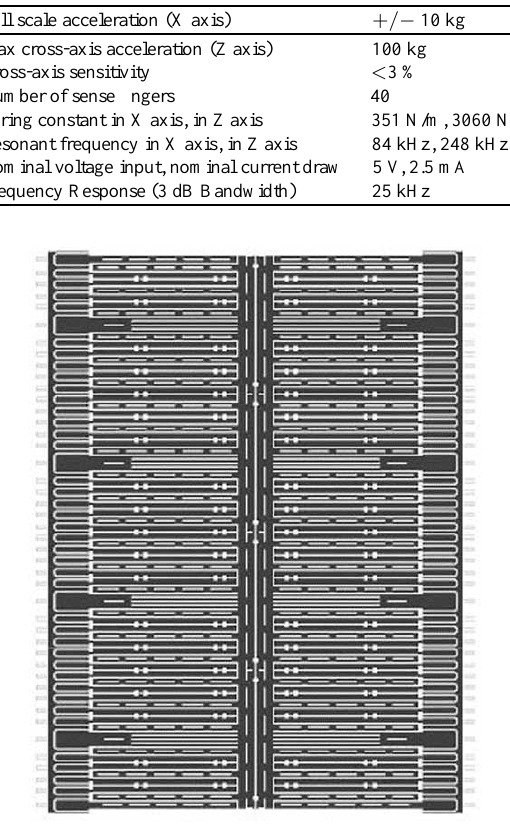
Fig. 2. Layout of the ADXSTC3-HG